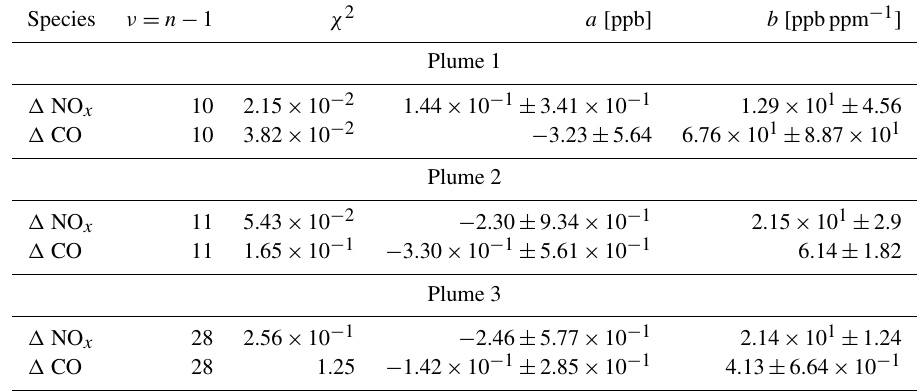
Table 1. Linear regression analysis for excess gas pollutant mixing ratio vs. excess carbon dioxide; [ (cid:49)X ] = a + b [ (cid:49) CO 2 ] , where X is any gas pollutant species; the uncertainty is computed using the orthogonal distance regression (ODR) method.